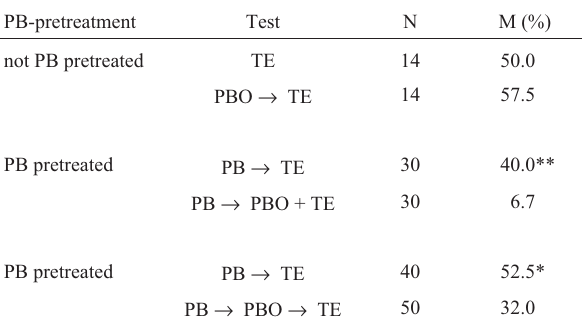
Table 3 - Comparative mortality (%) of A. aegypti L4 larvae from São José do Rio Preto in tests using temephos (TE) only or piperonyl butoxide (PBO) or phenobarbital(PB)beforeexposuretotemephos(PBO → TEorPB → TE),orusing the sequence of treatments (PB → PBO → TE or PB → PBO +